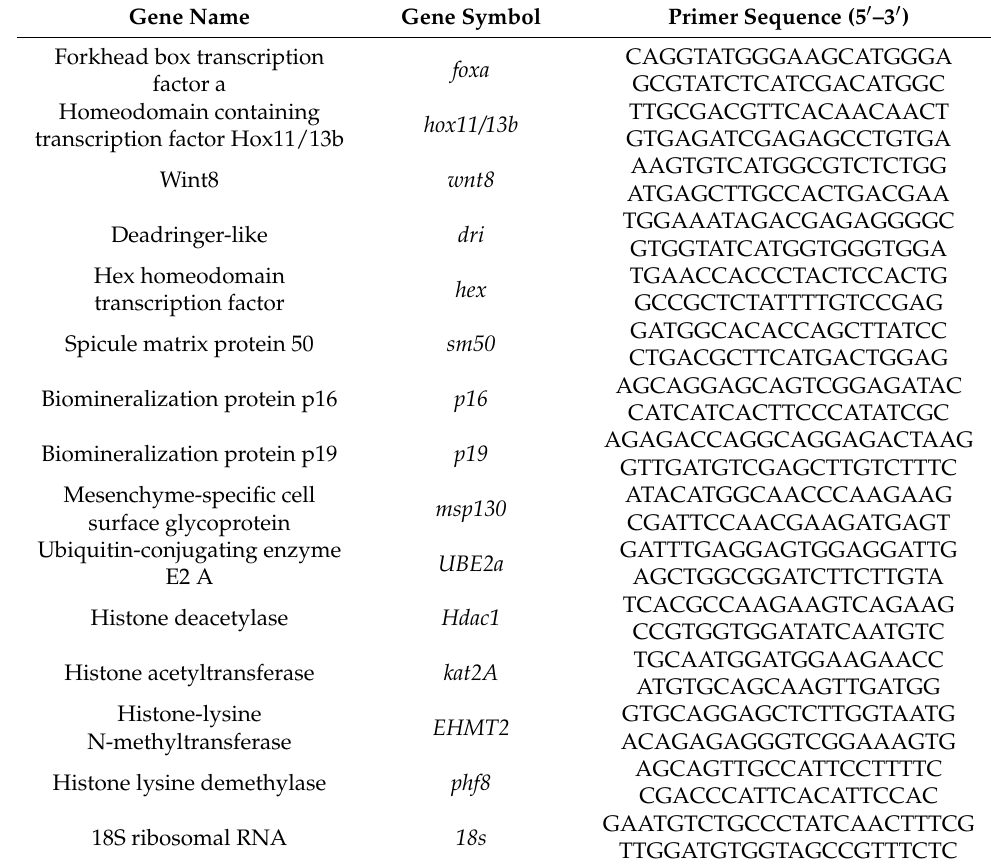
Table 2. Genes and oligonucleotide primers used in this